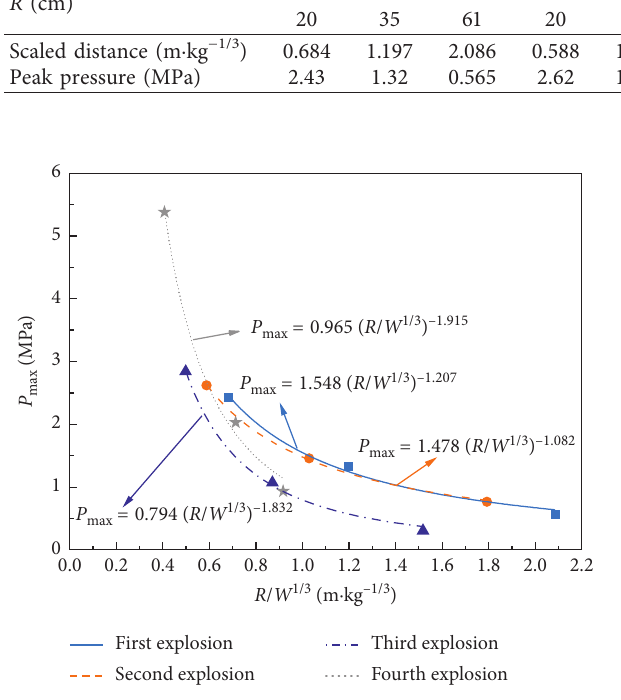
Figure 7: Attenuation formulas of peak pressure and scaled dis- tance after each explosion.